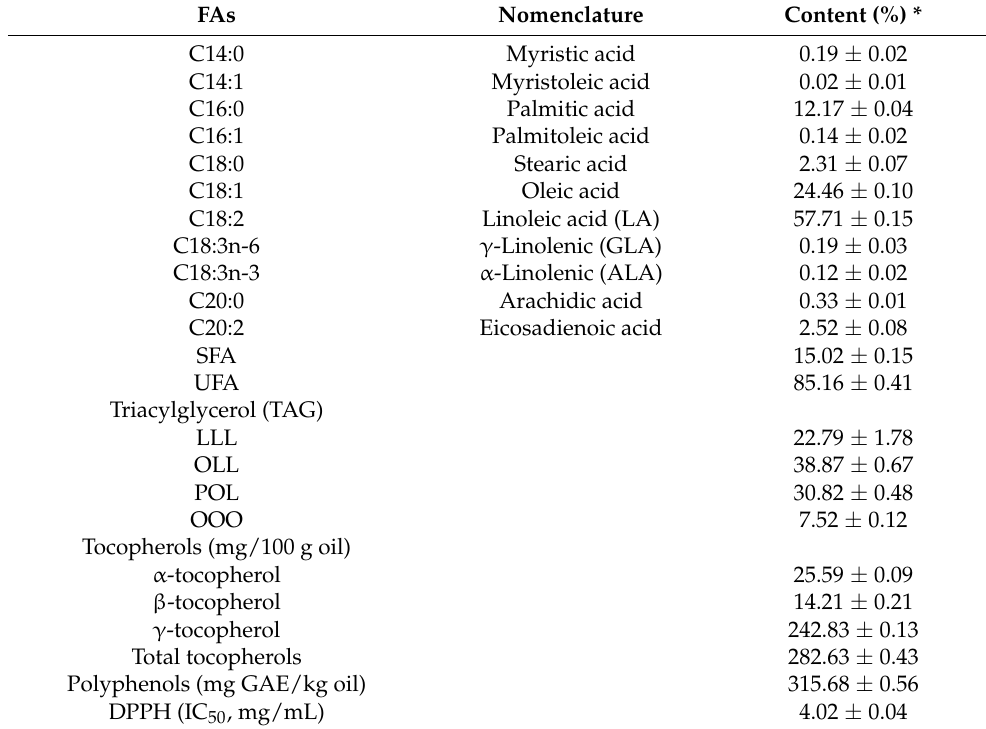
Table 4. Fatty acid composition of black seed ( Nigella sativa ) oil extracted by Soxhlet method.